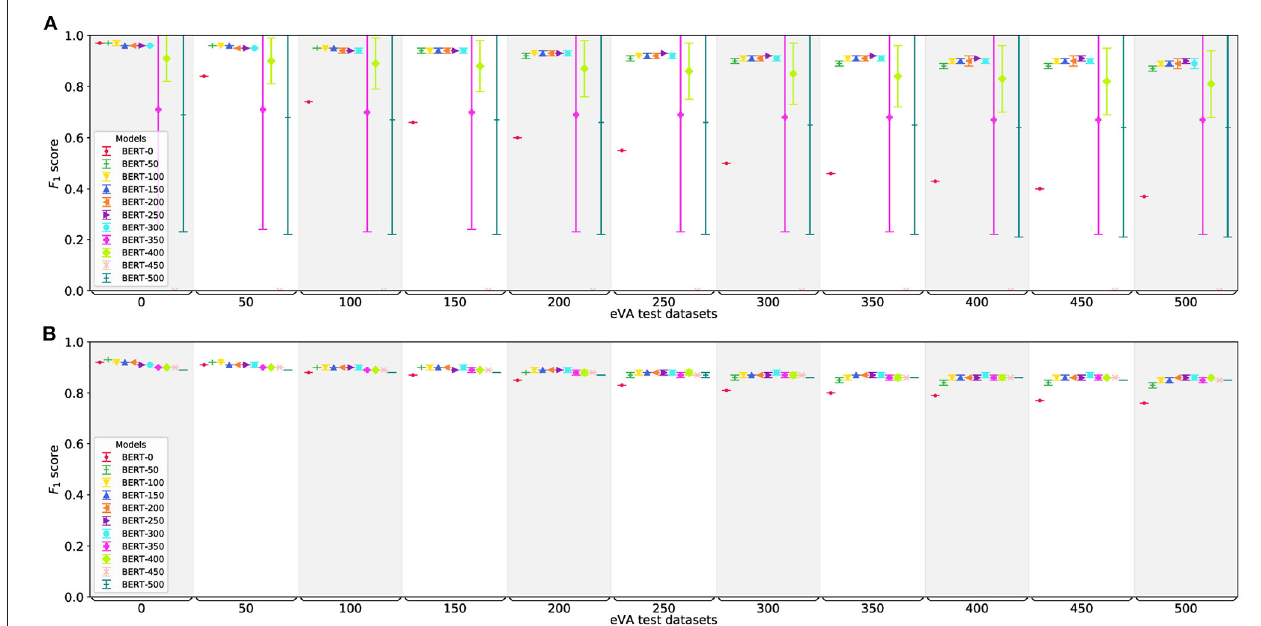
FIGURE 4 | Performance of BERT-CLF (A) and BERT-SEQ (B) trained and tested on different eVA datasets. The horizontal axis shows the different eVA test datasets, the model names represent the eVA training datasets the model is fine-tuned on. All models are trained five times with five different versions of each eVA training dataset. The figure shows the mean (horizontal line) and standard deviation (whiskers) of these